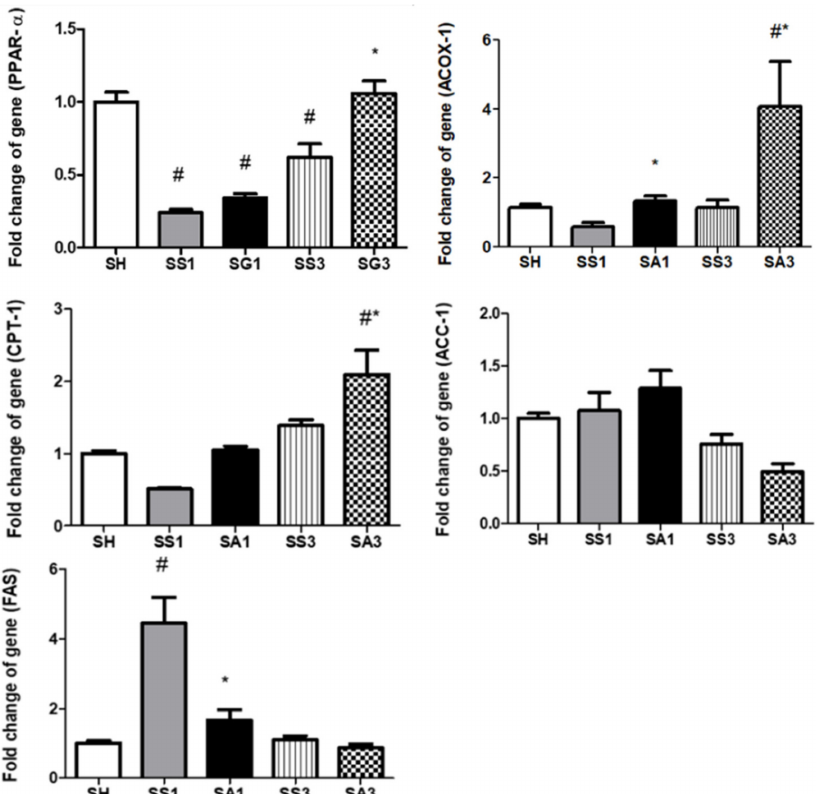
Figure 7. Messenger RNA expressions of lipid metabolism-associated genes in liver tissues. ACC, acetyl-CoA carboxylase; ACOX, acyl-CoA oxidase; CPT, carnitine palmitoyltransferase; FAS, fatty acid synthase; PPAR, peroxisome proliferator-activated receptor. SH, sham group without a sleeve gastrectomy (SG) ( n = 8); SS1 and SS3, saline groups sacrificed on day 1 or 3 after the SG; SA1 and SA3, arginine groups sacrificed on day 1 or 3 after the SG. n = 10 for each SG group. Values are presented as the mean ± SEM. A two-way analysis of variance (ANOVA) with the Bonferroni post-hoc test was used to analyze differences among the SH and gastrectomy groups. # Significantly differs from the SH group. * Significantly differs from the SS group at the same time point ( p < 0.05).